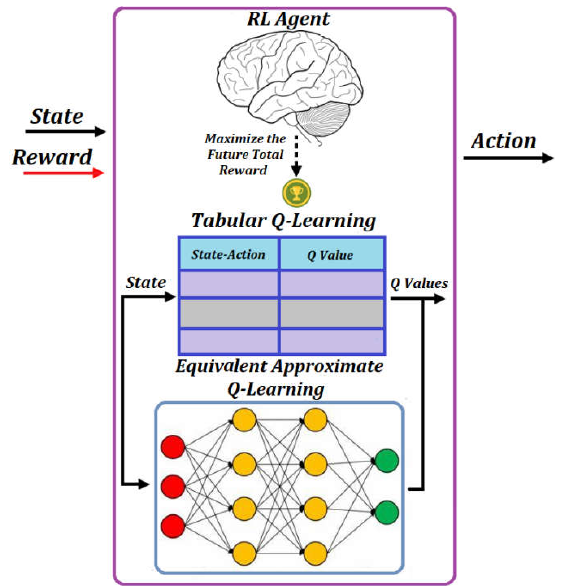
Figure 4. The DQN